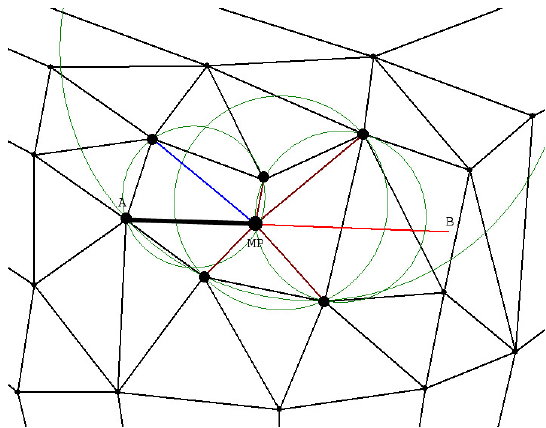
Figure 3 b) “Imaginary” circumcircles to MP